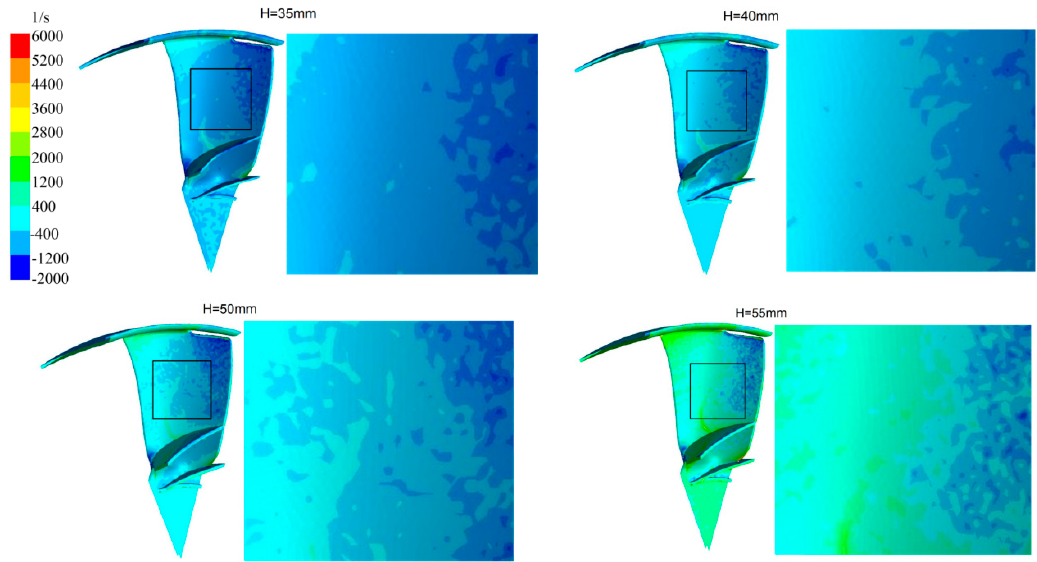
Figure 8. Distribution of CV on fan blade surface with different guiding fin heights.